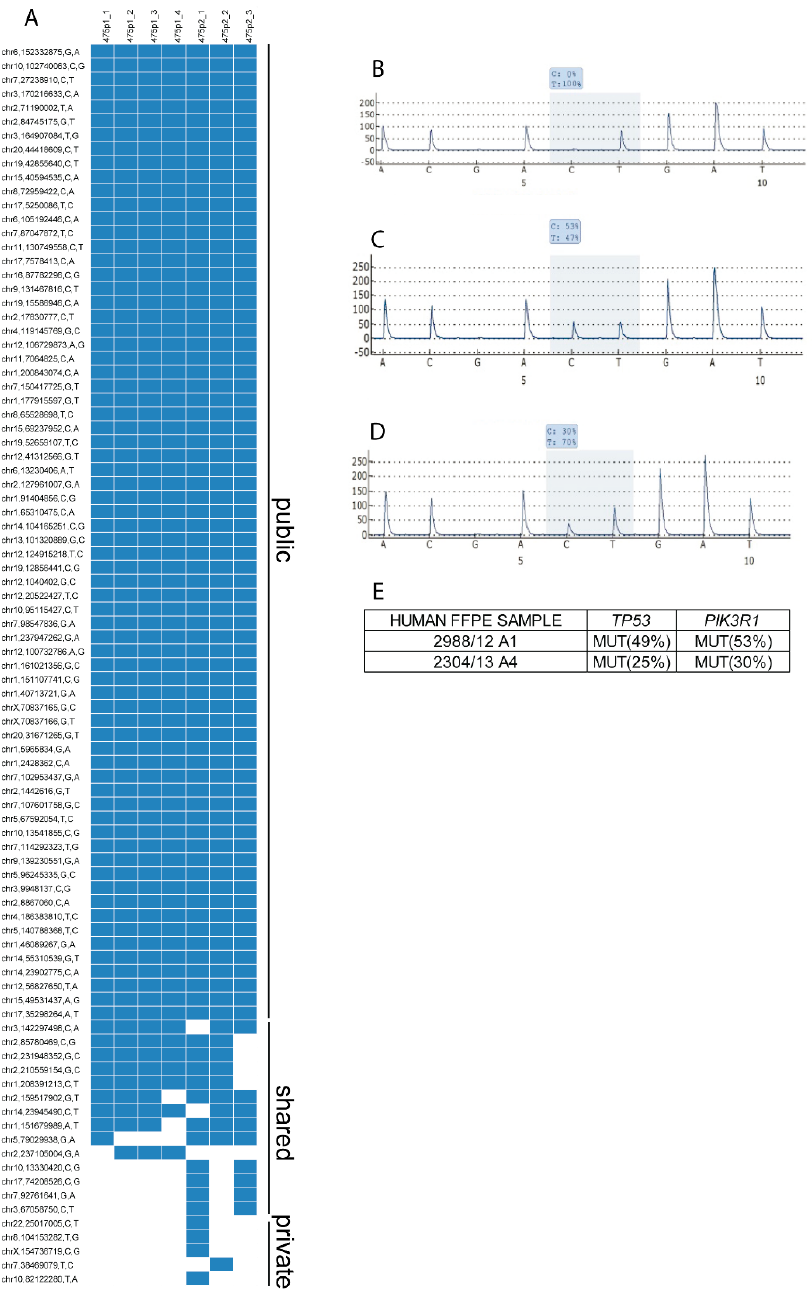
Figure 3. Identification of the PIK3R1 W624R mutation as truncal mutation in parallel and serial passages of the PDX line #475 and in the corresponding source tumour. ( A ) The W624R mutation in PIK3R1 is one of several public mutations found in seven parallel and serial passages of the PDX line#475. ( B – E ) Pyrosequencing analysis confirmed the presence of the TP53 and the PIK3R1 mutations found in the #475 PDX line in two FFPE samples from distinct blocks of the source tumour. The TP53 and the PIK3R1 mutated sequences showed the same allele frequency (AF) in each sample. The AF of the PDX line-specific TP53 mutation was considered as a proxy of the percentage of tumour cells in the human